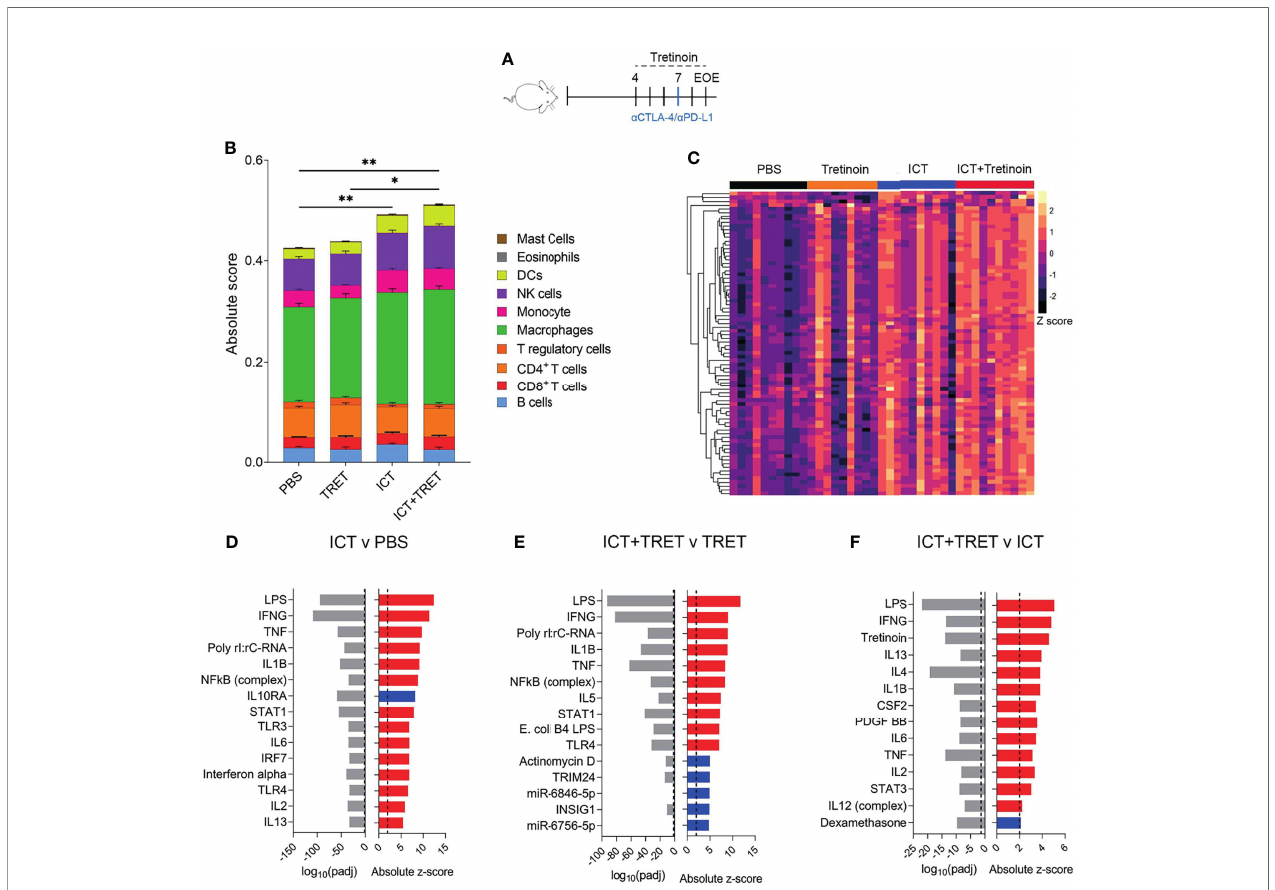
FIGURE 3 | The addition of tretinoin to ICT increases the expression of in fl ammatory genes and enhances immune in fi ltration compared to respective monotherapies. (A) Experimental design. Mice bearing AB1-HA tumours were treated with PBS, TRET, ICT or TRET+ICT. TRET treatment commenced day 4 (tumour size ~4 mm 2 ) for a total of 4 doses (5 mg/kg) and ICT commenced day 7 (anti-CTLA-4+anti-PDL1) with samples collected on day 9 and RNAseq performed. (B) Absolute immune score of tumours as determined by CIBERSORT. (C) Heatmap of interferon stimulated genes. Counts were VST normalized and Z scaled. (D) Positive (red) or negative (blue) upstream regulators of differentially expressed genes between ICT treated versus control tumours and associated p value (grey). (E) Upstream regulators of the differentially expressed genes between TRET+ICT treated tumors versus TRET monotherapy. (F) Upstream regulators of differentially expressed genes between TRET +ICT treated tumours and ICT monotherapy treated tumours. PBS (n=10), TRET (n=9), ICT (n=10) or TRET+ICT (n=10). Signi fi cance determined using a Mann-Whitney U test corrected for multiple comparisons. *p < 0.05 **p <